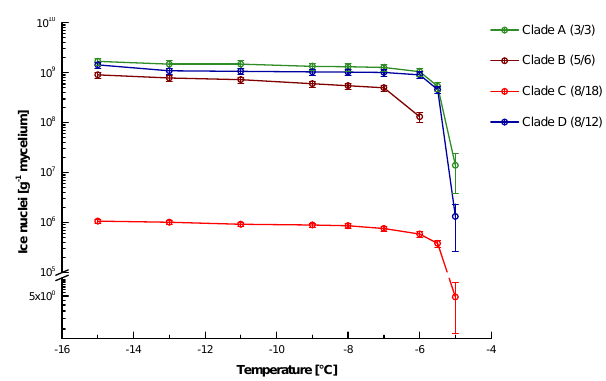
Figure 3. Average number of IN per gram of mycelium for the iso- lates of different soil types. The numbers in parentheses represent the number of isolates tested out of the total number of isolates each sampling site. Error bars represent the 95% confidence